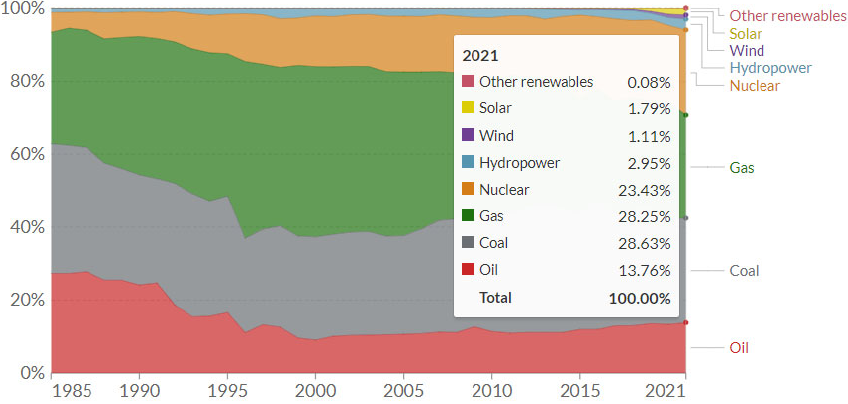
Figure 2. Structure of primary energy consumption in Ukraine by source. Source: [24].